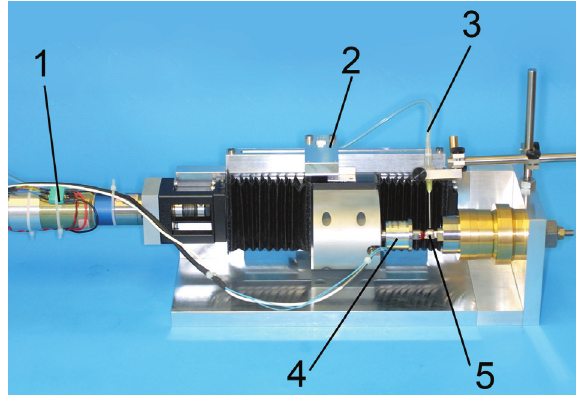
Figure 3- Wear apparatus: Digitally controlled electric motor with (1); Light barrier limiting the covered distance to the insertion and separation path (2); Artificial